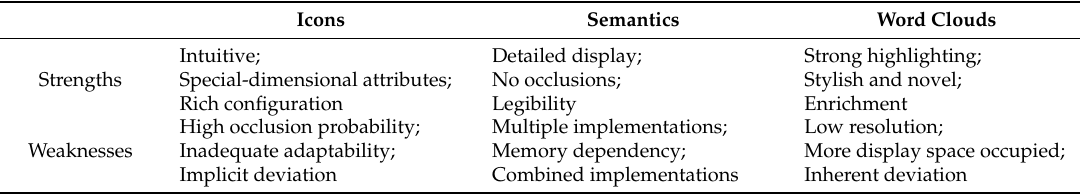
Table 1. Overview comparing strengths and weaknesses of multivariate visualization